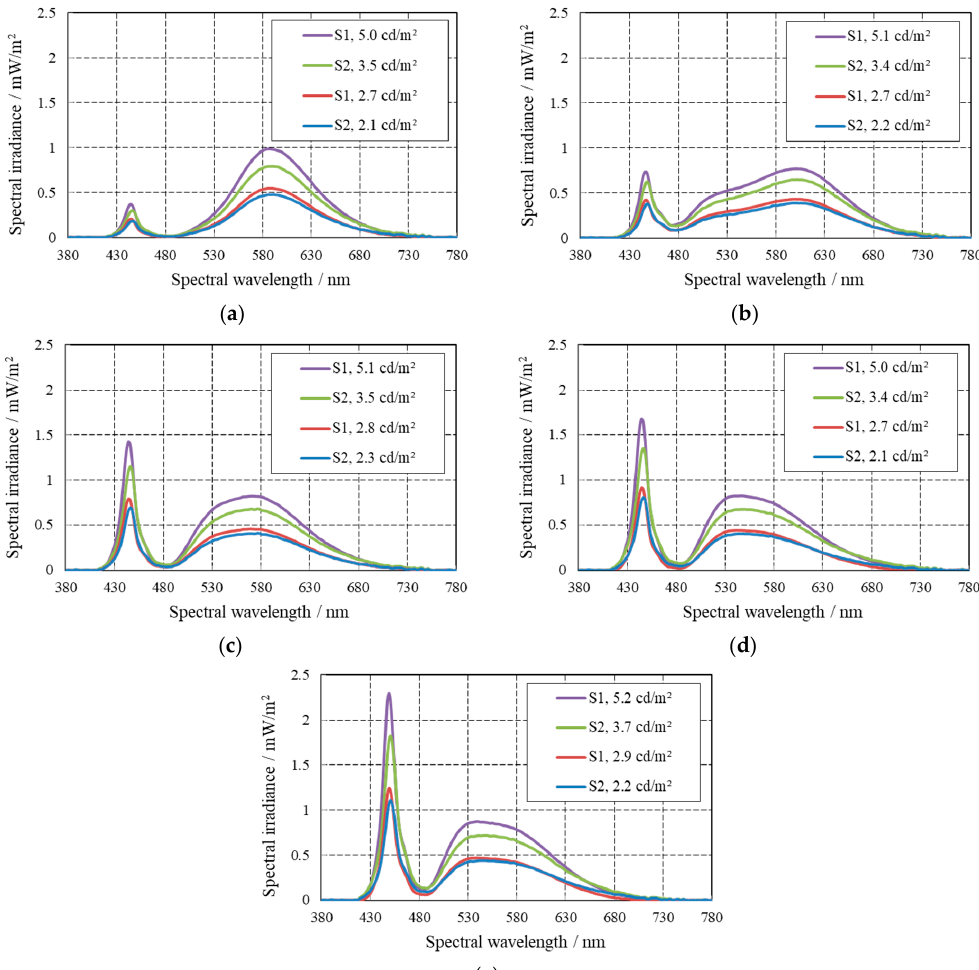
Figure 7. Spectral distribution of LED light sources (S1 and S2 represent sidewalls with energy- storage and luminescent coating and gray cloth, respectively). ( a ) 2500 K, ( b ) 3500 K, ( c ) 4500 K, ( d ) 5500 K, ( e ) 6500 K.